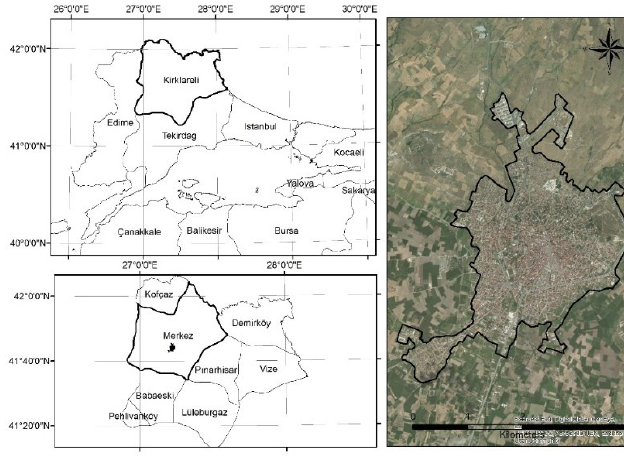
Figure 1. Location Map of Study Area.